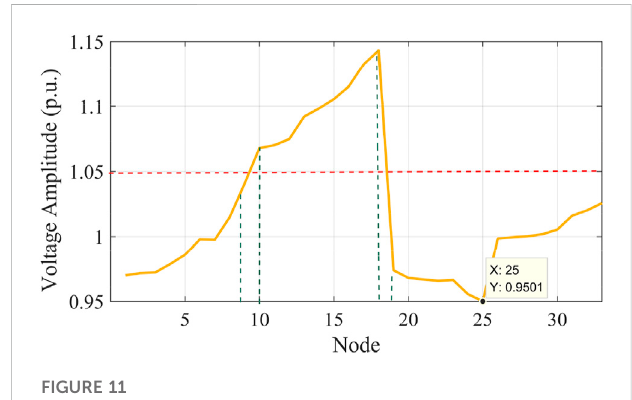
FIGURE 11 Voltage amplitude of each bus node after adjusting OLTC.